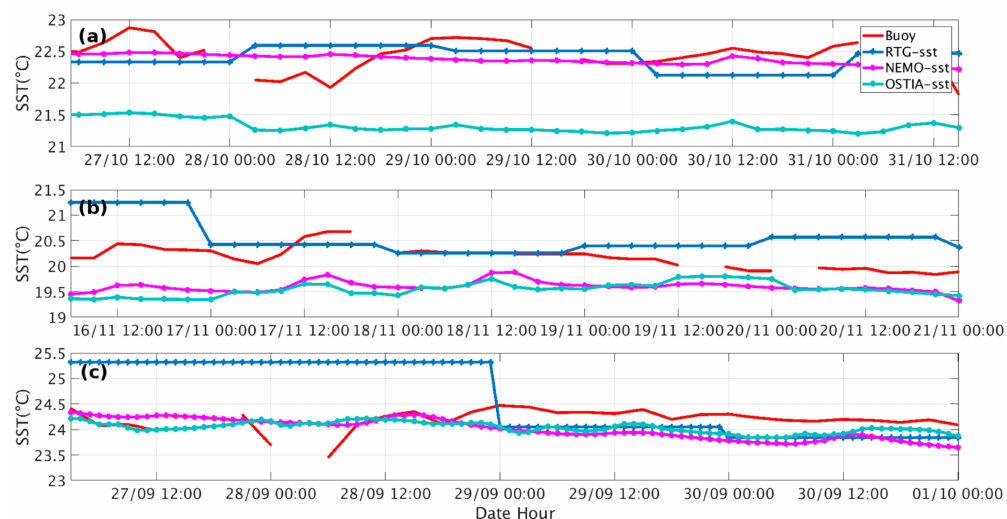
Figure 6. RTG, NEMO, OSTIA and recorded SST evolution at a selected location of the 61277 buoy during ( a ) cyclone Trixi (2016), ( b ) cyclone Numa (2017), and ( c ) cyclone Zorbas